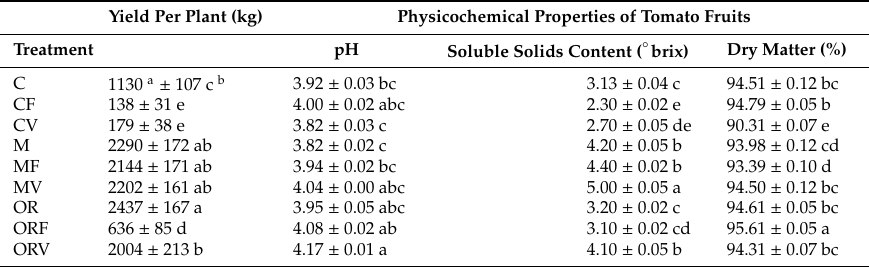
a Each mean represents the average of 24 determinations [12 replications (plants) × 2 experiments]. b Means in columns followed by the same letter were not statistically significant di ff erent at p < 0.05 according to Bonferroni adjusted LSD value (LSD B values for yield / plant = 312.2, pH = 0.223,